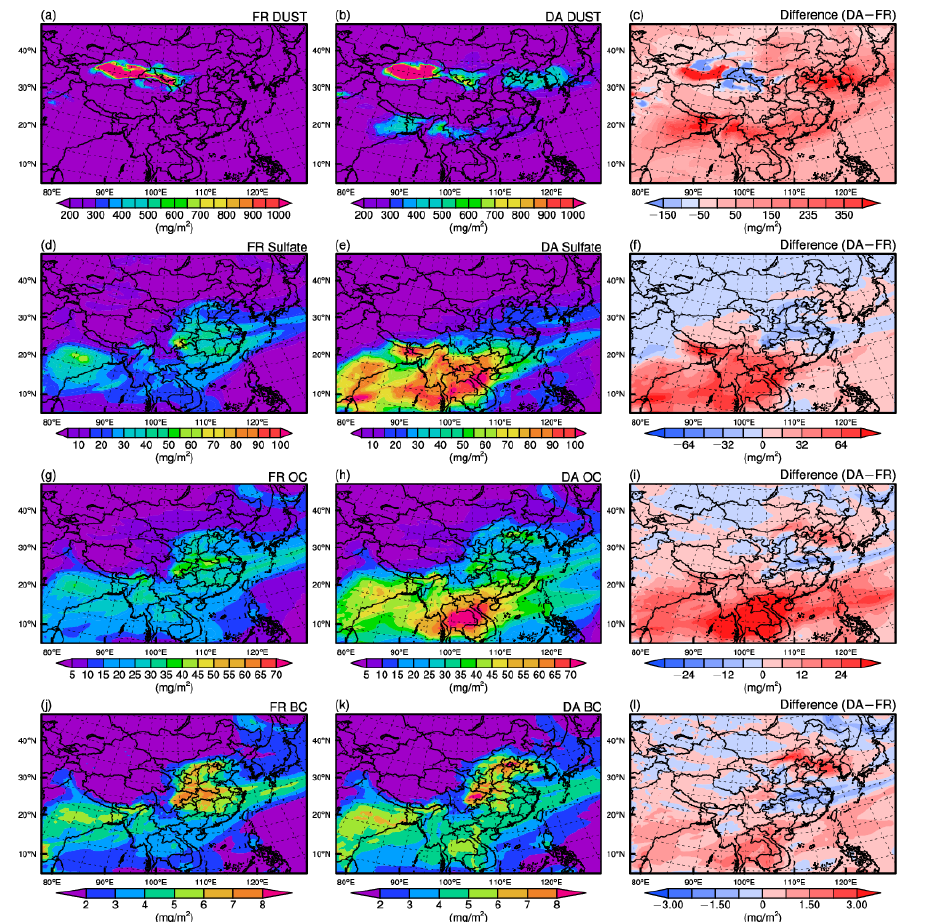
Figure 3. Spatial distributions of the daily mean values of the aerosol burdens for each component (including dust, sulfate, organic carbon [OC], and black carbon [BC]) in the FR ( a , d , g , j ) and DA ( b , e , h , k ) experiment and their differences ( c , f , i , l ) on 16 March 2021. The difference is defined as the result of the DA experiment minus that of the FR